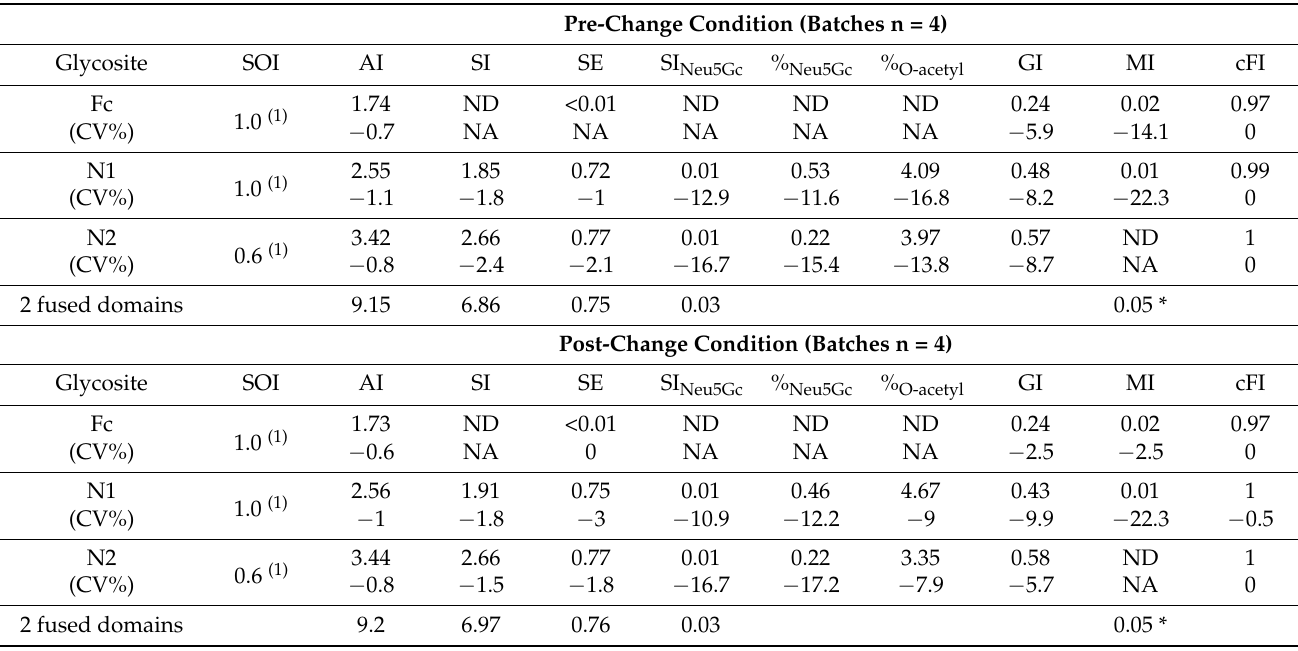
Table 7. Glycosylation comparability matrix after a process change: two process conditions, pre- change and post-change, were compared by analyzing four batches per process condition, and samples were analyzed in the same analytical session. The table summarizes the average values and variation coefficients of selected glycosylation indices. Pre-Change Condition (Batches n =